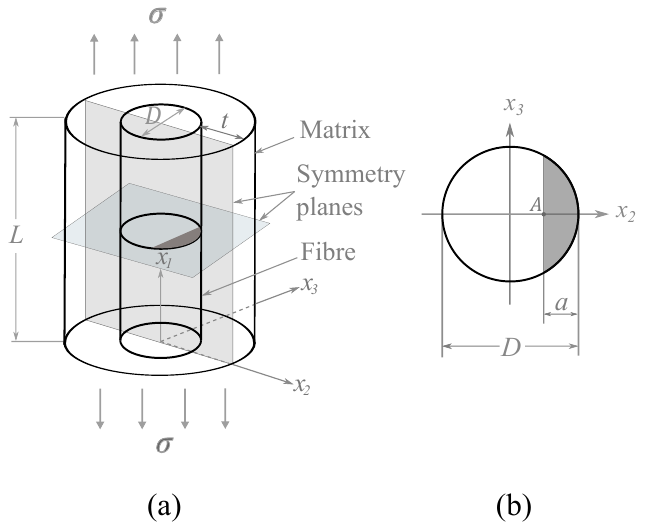
Figure 1. ( a ) 3D geometry of a notched fibre with straight-fronted edge crack (indicated in grey) embedded in a matrix; ( b ) fibre cross-section at crack